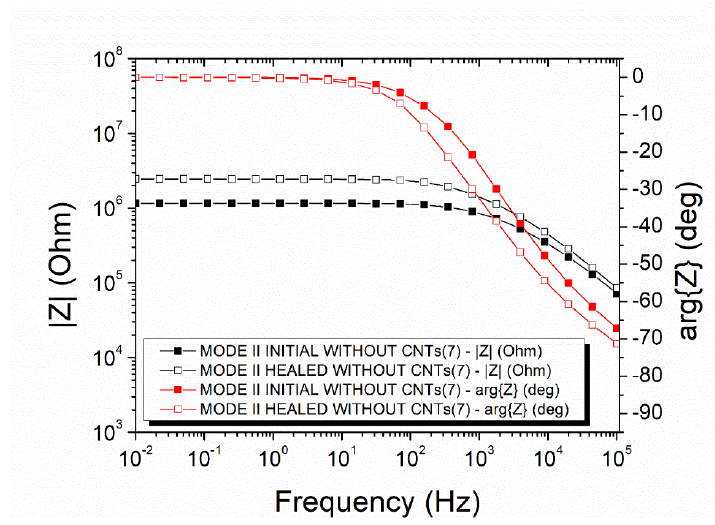
Figure 7. Representative impedance plots of a mode-II specimen with neat micro-capsules.